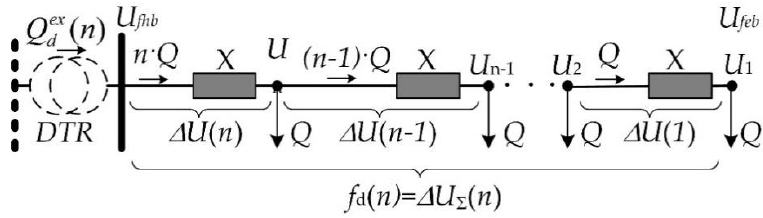
Figure 4. Equivalent circuit of a low-voltage (LV) feeder with distributed var-sinks.